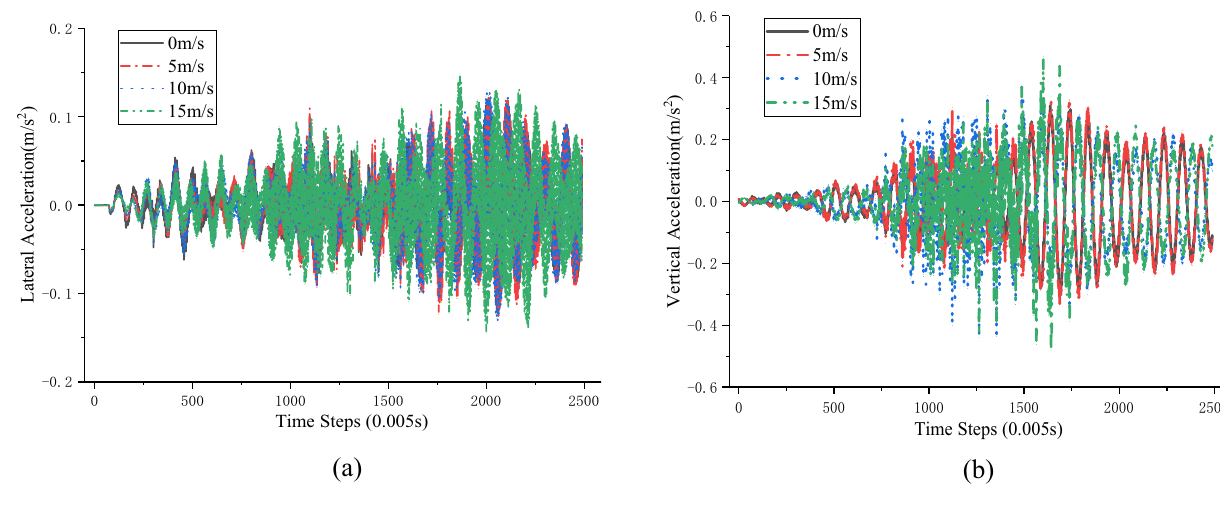
Fig. 11 STM bridge time history curves of accelerations. a lateral acceleration; b vertical